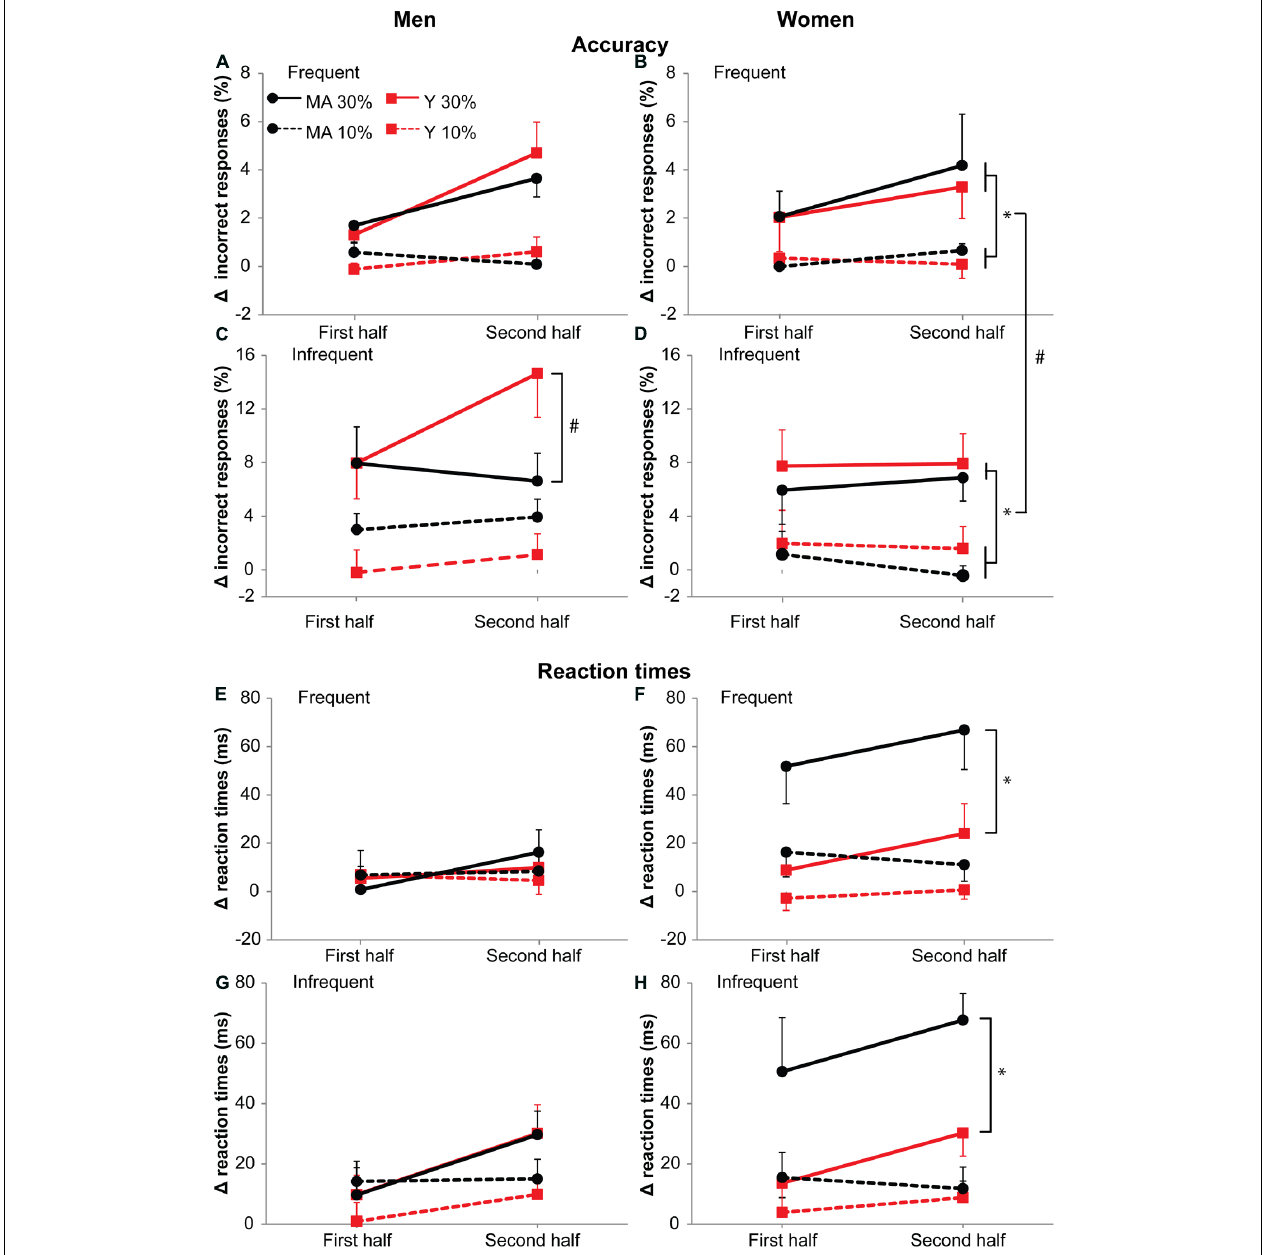
10%-dual-task (10% cMVC). Data are shown for the first and second half of the task. Error bars represent SE. * shows main effects, # shows interaction effects.Young men showed on infrequent stimuli (C) an increase in errors with time on the 30%-dual-task. Middle-aged women (F,H) showed a large increase in reaction times from the single- to the dual-task (graphs shows deltas) during the 30%-dual-task.